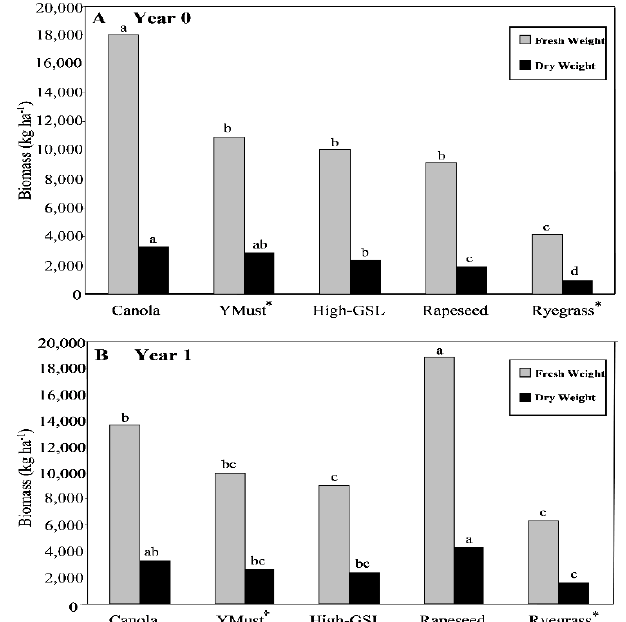
Figure 1. Fresh and dried weights of rotation crop biomass from the Central Aroostook site in ( A ) Year 0 and ( B ) Year 1 of the trial, respectively, taken immediately prior to incorporation. Values were derived from 1/8 m 2 quadrat samples. Means for each sample type (fresh and dry) for each year with the same letter are not significantly different according to Fisher’s protected LSD at P = 0.05. * Yellow mustard and ryegrass were not incorporated and left on soil surface as residues.